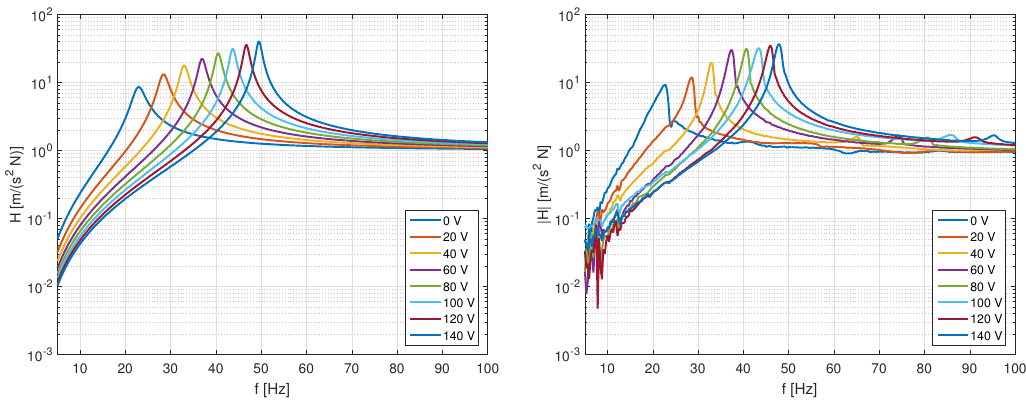
Figure 9. Frequency response functions of the adaptive vibration absorber for different DC voltages.